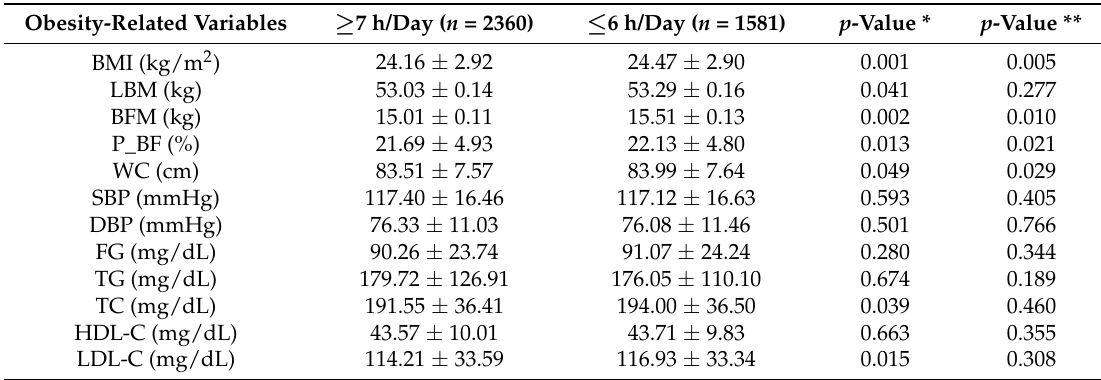
Table 2. Obesity-related variable according to sleep duration in Korean men.